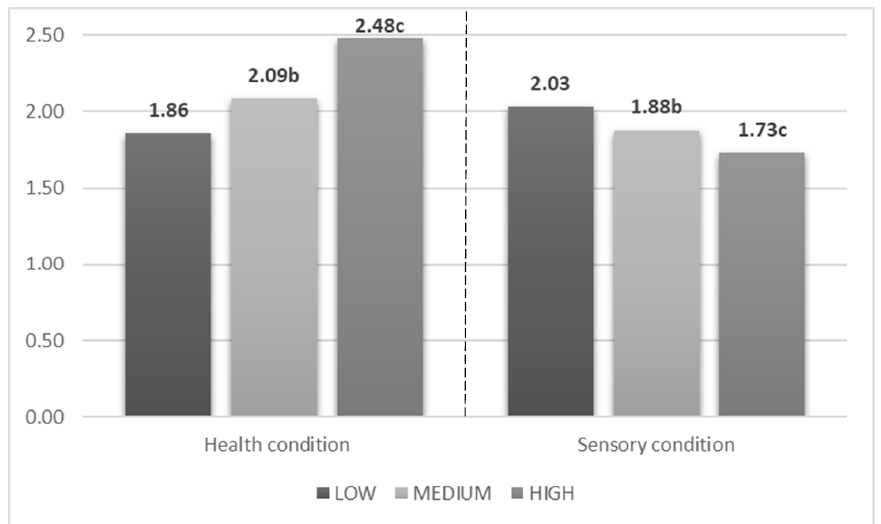
Figure 4. Mean WTP ( € ) in the Expected round. Note: Mean bids with different superscripts are significantly different according to a Wilcoxon test for paired samples ( p < 0.05) within the information treatments.